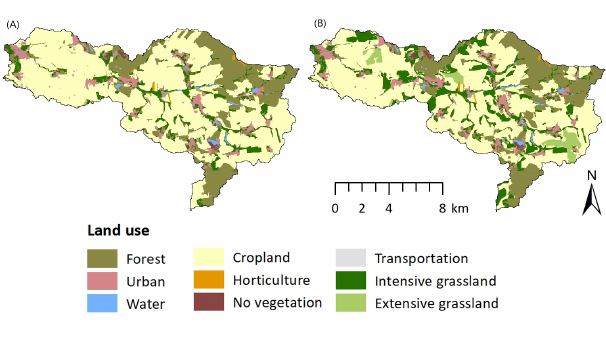
Fig. 4. Land-use map of the Lossa River basin for the status quo (A) and the optimal solution with highest social welfare (Biomax;